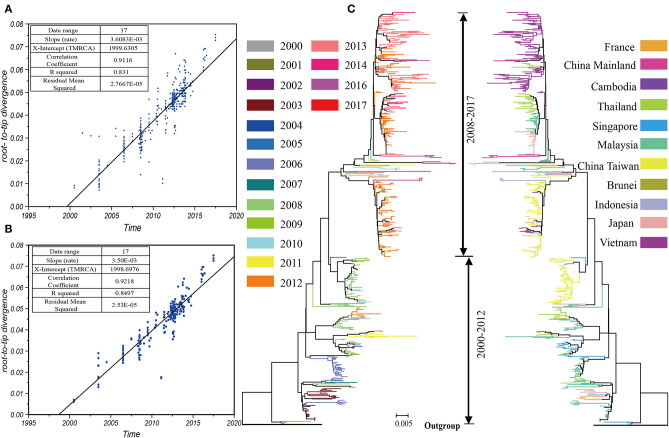
The prevalence of the B5 subgenotype of EV-A71 is divided into two stages. The root-to-tip diagnostic tool using heuristic residual mean square methods suggested that data redundancy and discrete nodes existed in the total dataset (A) and the compact dataset (B); the phylogenetic tree indicated the recent epidemics (after 2012) were mostly found in the end of a branch of the evolutionary tree (C).